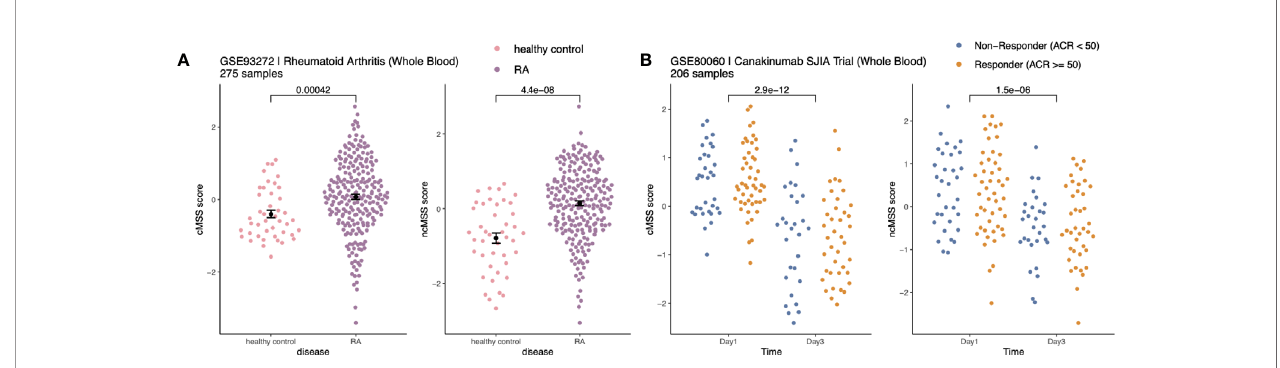
FIGURE 5 | Monocyte subset signatures reveal speci fi c changes in immune cell-composition in disease and treatment: (A) Increase in monocyte levels in Rheumatoid Arthritis (RA) patients compared to healthy controls. Signi fi cance measured by Wilcoxon ’ s Rank Sum Test. (B) Reduction in monocyte after Canakinumab treatment of SJIA patients independently of response. Signi fi cance measured by Wilcoxon ’ s Rank